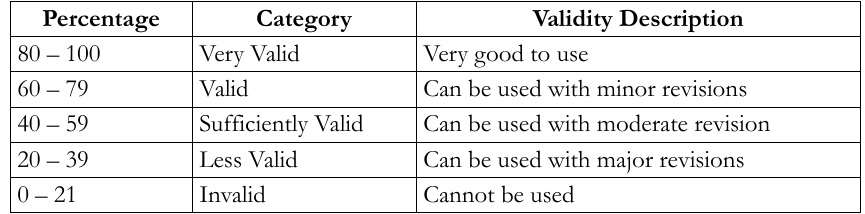
Table 1. Learning Media Validation Criteria (Bani & Masruddin,